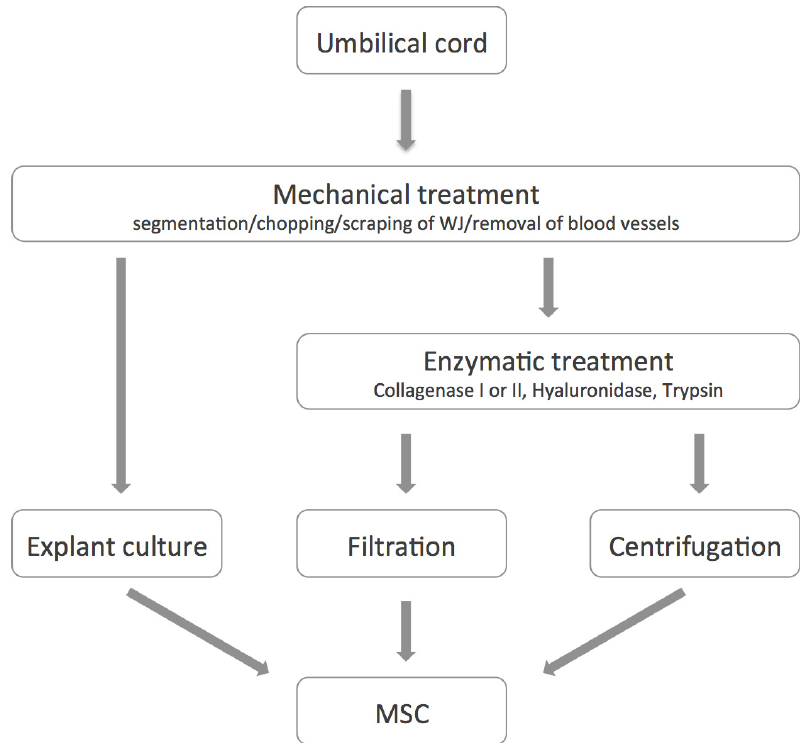
Figure 1. Different techniques used during isolation of mesenchymal stem or stromal cells (MSC) from umbilical cord (UC) tissue. Basically enzymatic digestion or explant culture approaches are